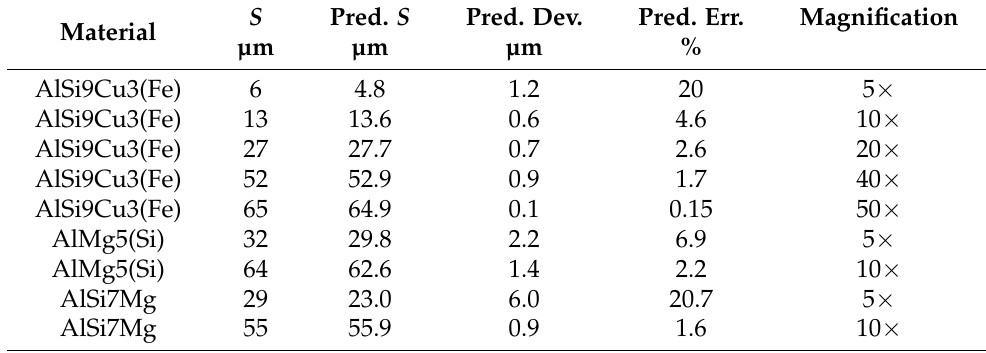
Table 3. Results of prediction for materials used during training.